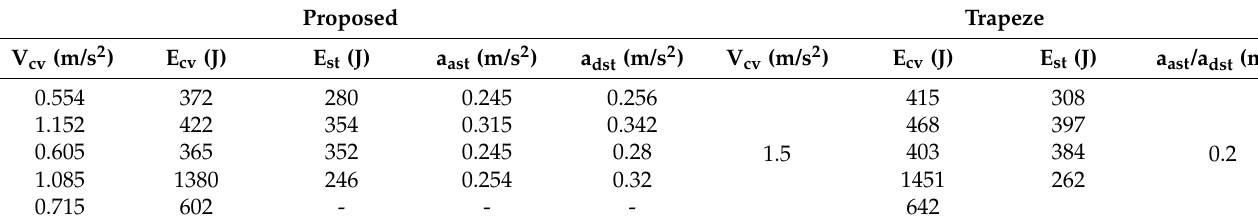
Table 3. Task motion analysis with the proposed method.